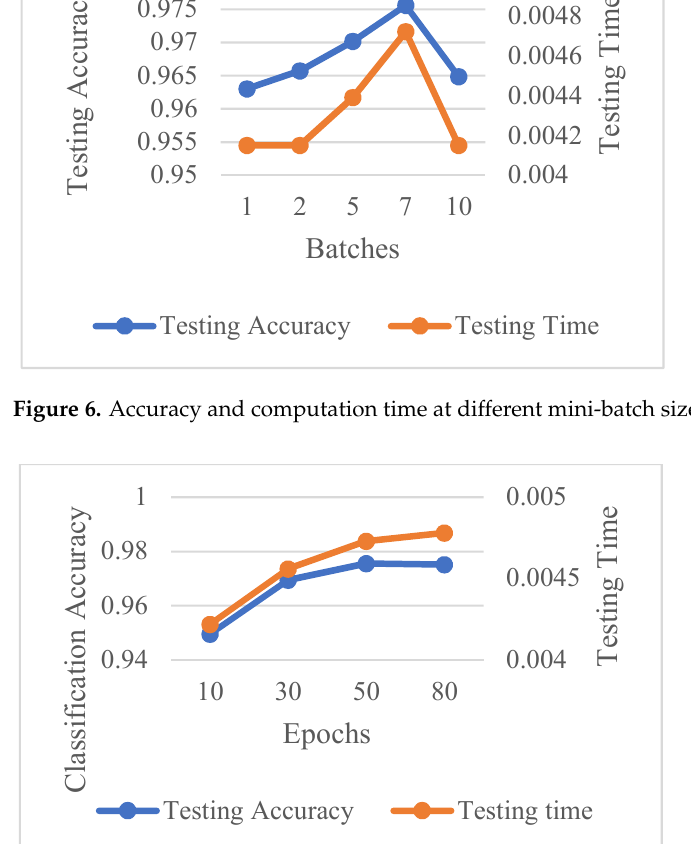
Figure 7. Accuracy and computation time at different maximum numbers of epochs.